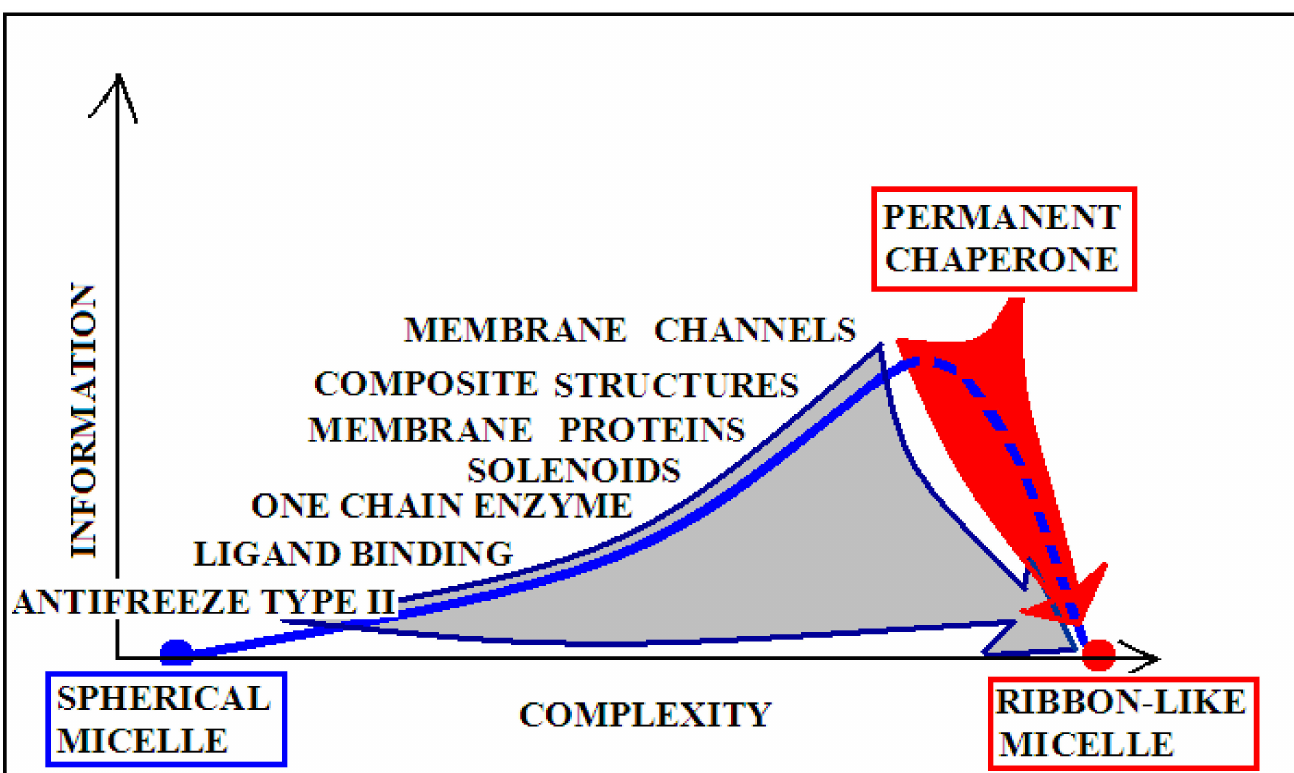
Figure 9. Graphical presentation of the relationship of the degree of complexity of the protein structure and the amount of information encoded in the structure that guarantees a specific biological activity. Proteins with a spherical micellar structure determined by sequence and a ribbon-like micellar form show the lowest demand for external information. The aquatic environment is a sufficient source of information. The more complex the structure (complexes), the greater the information expenditure. The position of “permanent chaperone” defines the status of a protein that fulfills its biological role only by interacting with the appropriate organelles. The absence of the “partner” results in a change of structure solely due to the influence of the aquatic environment (red arrow). The gray arrow shows the transformation forced by the change of the environmental factor (shaking) resulting from the experiment. Dashed line—pathological